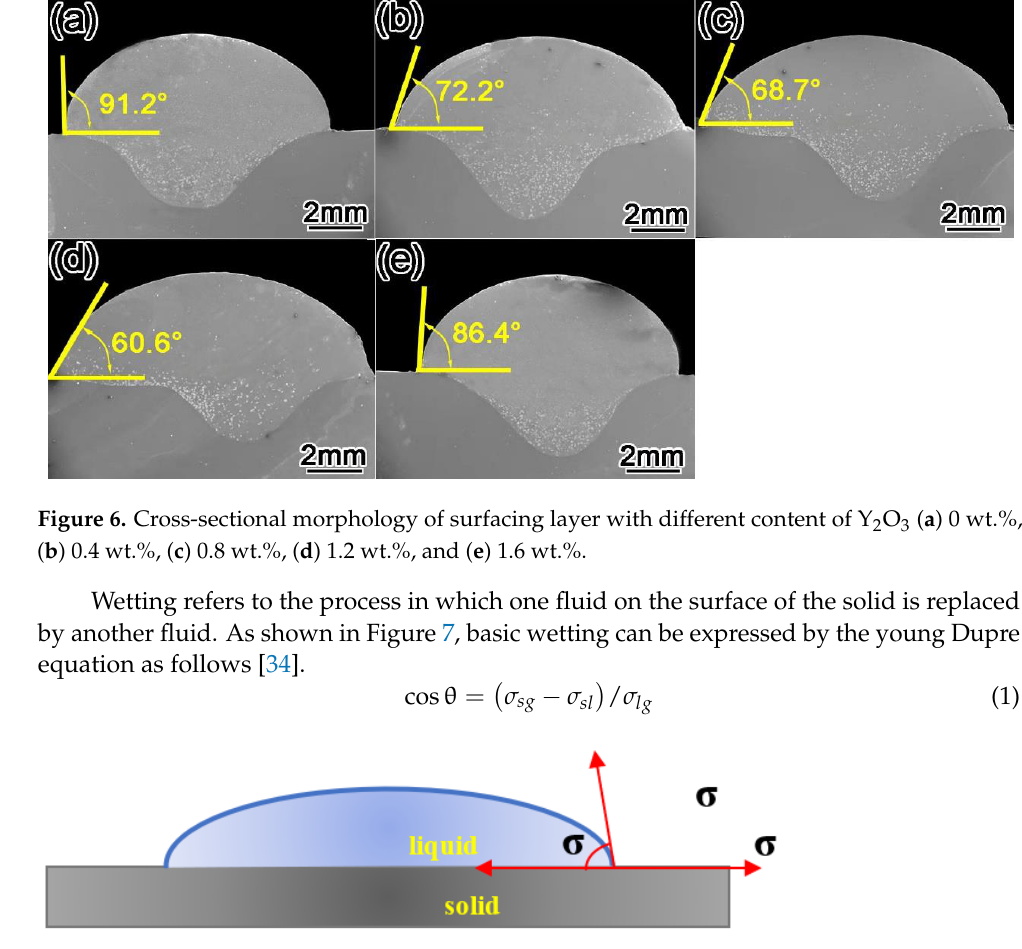
Figure 5. Macro morphology of surfacing layer with different content of Y 2 O 3 ( a ) 0 wt.%, ( b ) 0.4 wt.%, ( c ) 0.8 wt.%, ( d ) 1.2 wt.%, and ( e ) 1.6 wt.% Figure 6 shows the cross-sectional shape of the surfacing layer perpendicular to the welding direction in which Y 2 O 3 content is 0 wt.%, 0.4 wt.%, 0.8 wt.%, 1.2 wt.%, and 1.6 wt.%, respectively. It can be seen from the figure that with the increase in Y 2 O 3 content, the wetting angle decreases first and then increases.